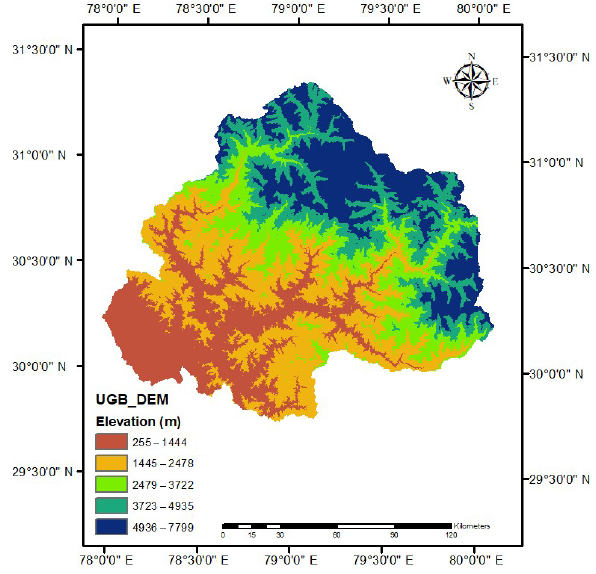
Figure 1. Graphical representation of the study area, the upper Ganga